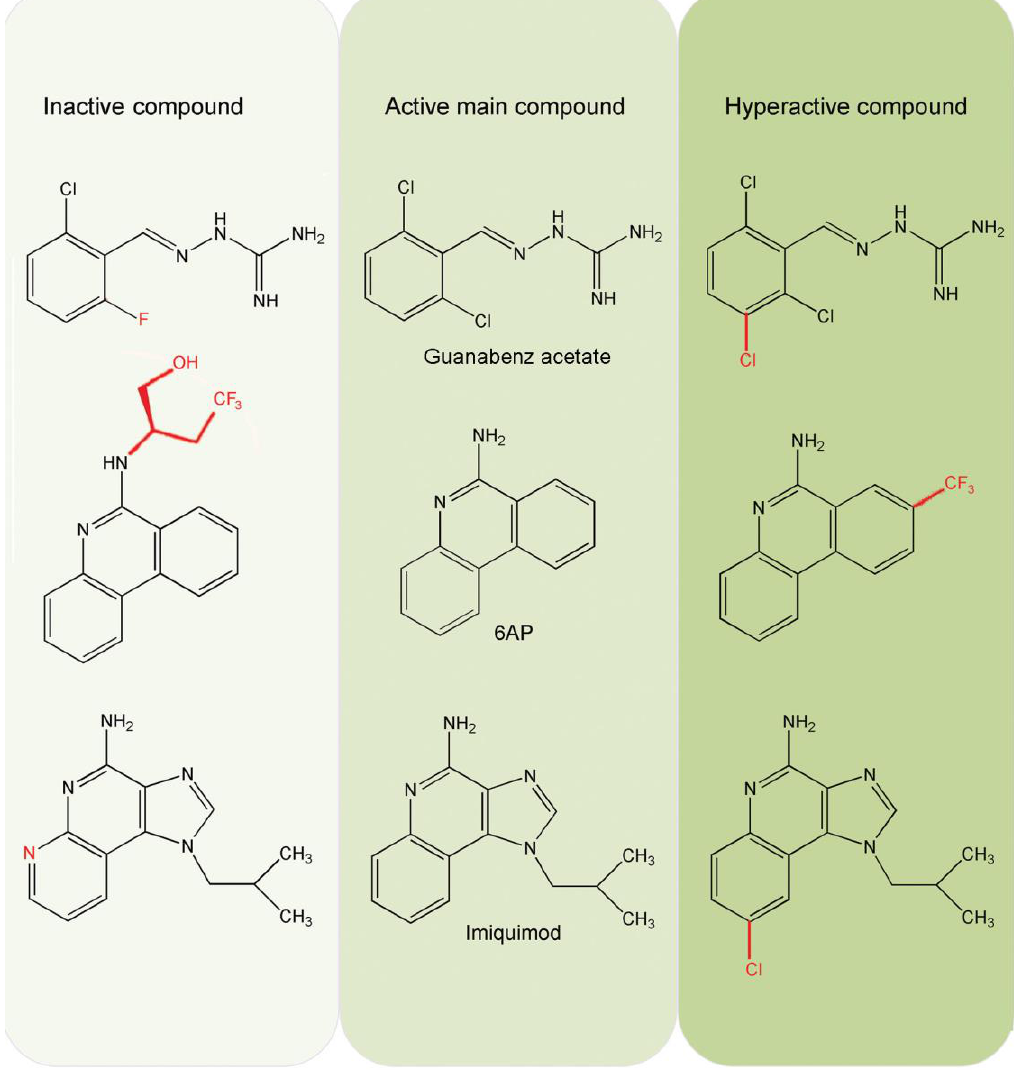
Figure 2. The effect of substitutions on the antiprion activity of 6-aminophenanthridine (6AP), guanabenz acetate and imiquimod derivatives. The primary compounds are in the middle column, while substituted compounds are on the left (inactive) and right (hyperactive). The substitutions are indicated in